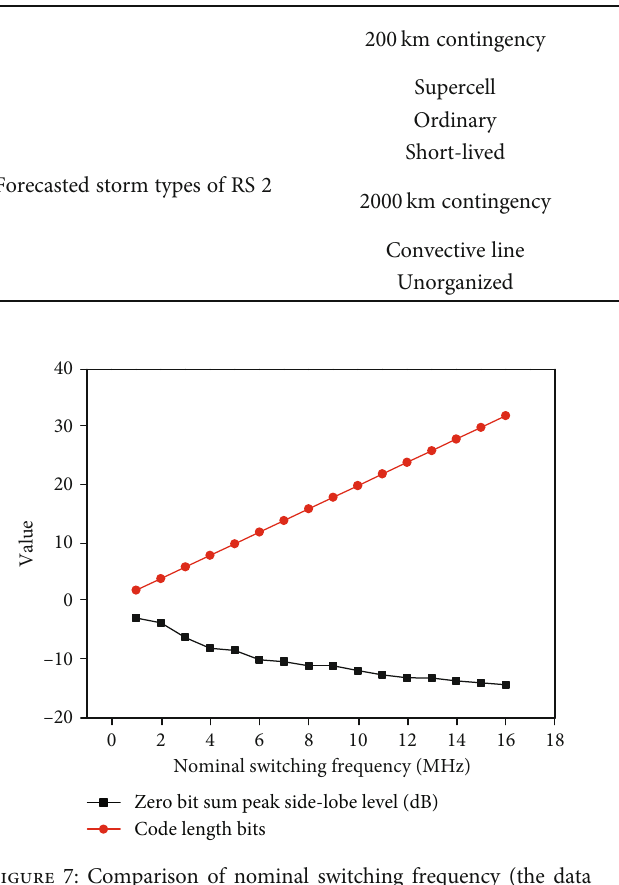
Figure 6: Comparison of the di ff erent optimization waveforms of the RS. Table 2: Comparison of data acquisition for di ff erent radar types at 200 km and 2000km contingency [61].